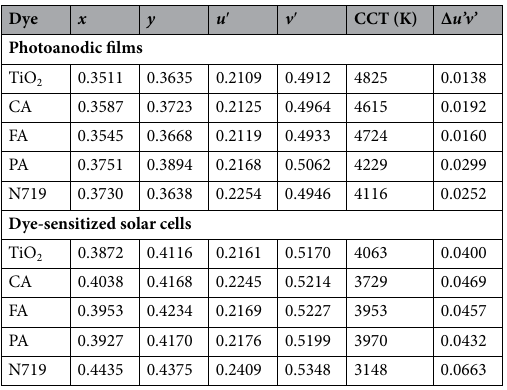
Table 4. Chromaticity coordinates ( x , y ), ( u ′ , v ′ ), CCT, and color difference (Δ u ′ v ′ ) of the light transmitted through the TiO 2 -only, CA, FA, PA, and N719 photoanodic films and their solar